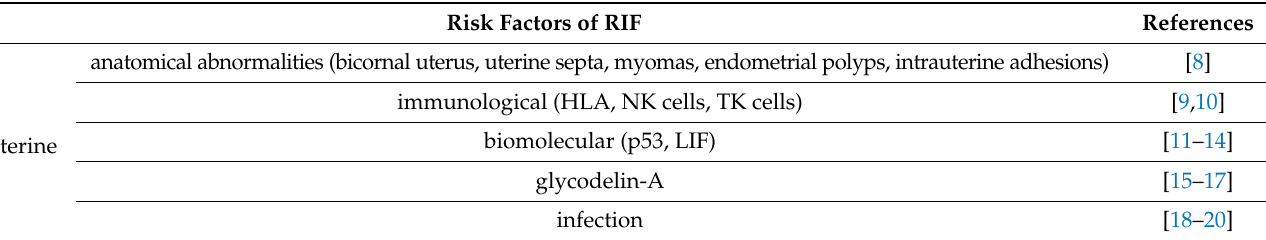
Table 1. The frequent risk factors of RIF. Risk Factors of